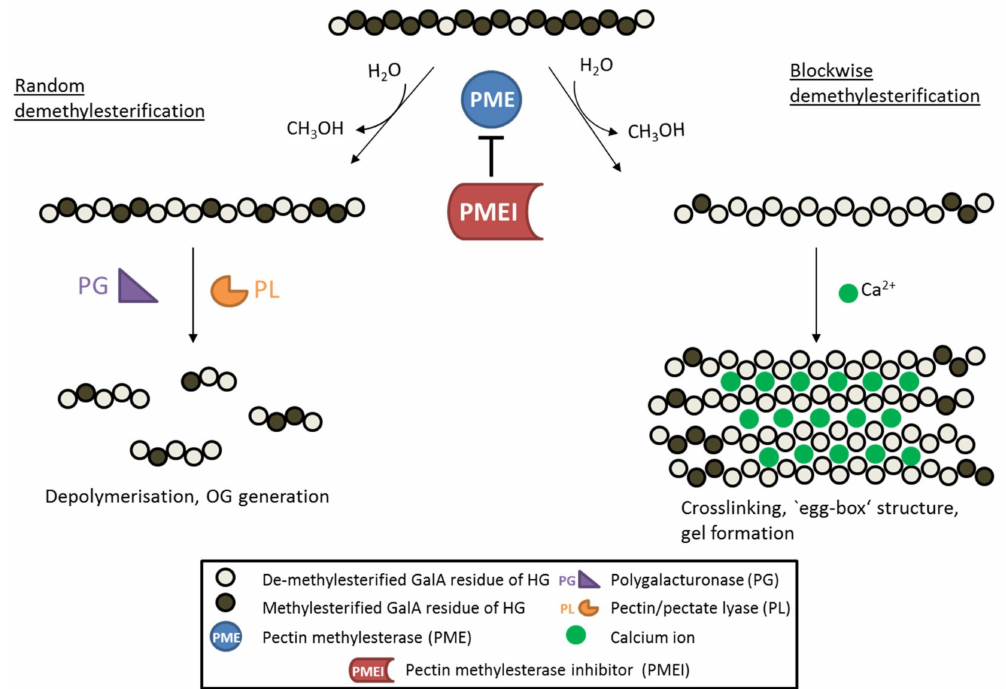
Figure 1. Schematic diagram showing the de-methylesterification of HG and the effects on its structure. HG is highly methylesterified when deposited into the cell wall. PMEs can de-methylesterify HG in a block-wise fashion, leading to several consecutive GalA residues without methylester groups. These HG backbones are negatively charged and can therefore form crosslinks with cations like calcium ions, leading to so called ‘egg-box‘ structures responsible for gel formation. On the other hand, PMEs can de-methylesterify single GalA residues leading to a random methylesterification pattern. Low-methylesterified HG is depolymerized by pectin-degrading enzymes such as polygalacturonases (PG) and pectin/pectate lyases (PL), which leads to the formation of oligogalacturonides (OG). PME activity is inhibited by its proteinaceous inhibitor